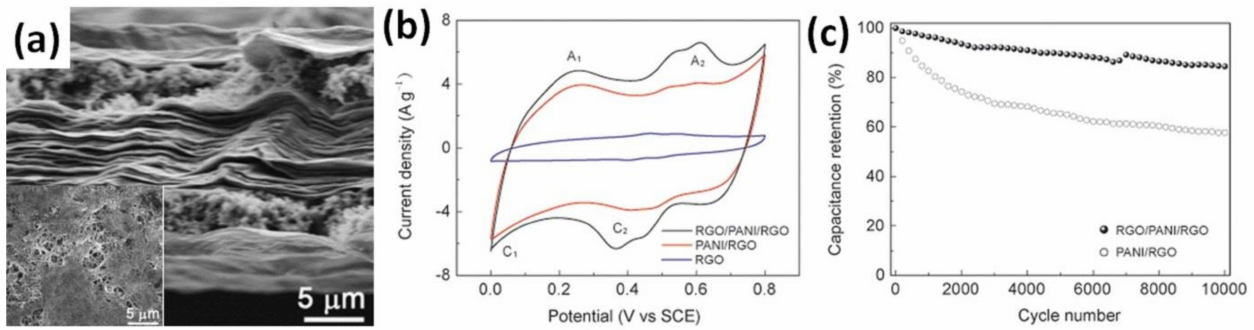
Figure 5. Cross-sectional view of microstructure of rGO/PANI/rGO papers ( a ) (inset is top view). CV curves of rGO/PANI/rGO, PANI/rGO and rGO paper electrodes at a scan rate of 10 mV/s in 1 M H 2 SO 4 electrolyte ( b ). Cycle performance of rGO/PANI/rGO and PANI/rGO paper electrodes at 10 A/g over 10,000 cycles ( c )